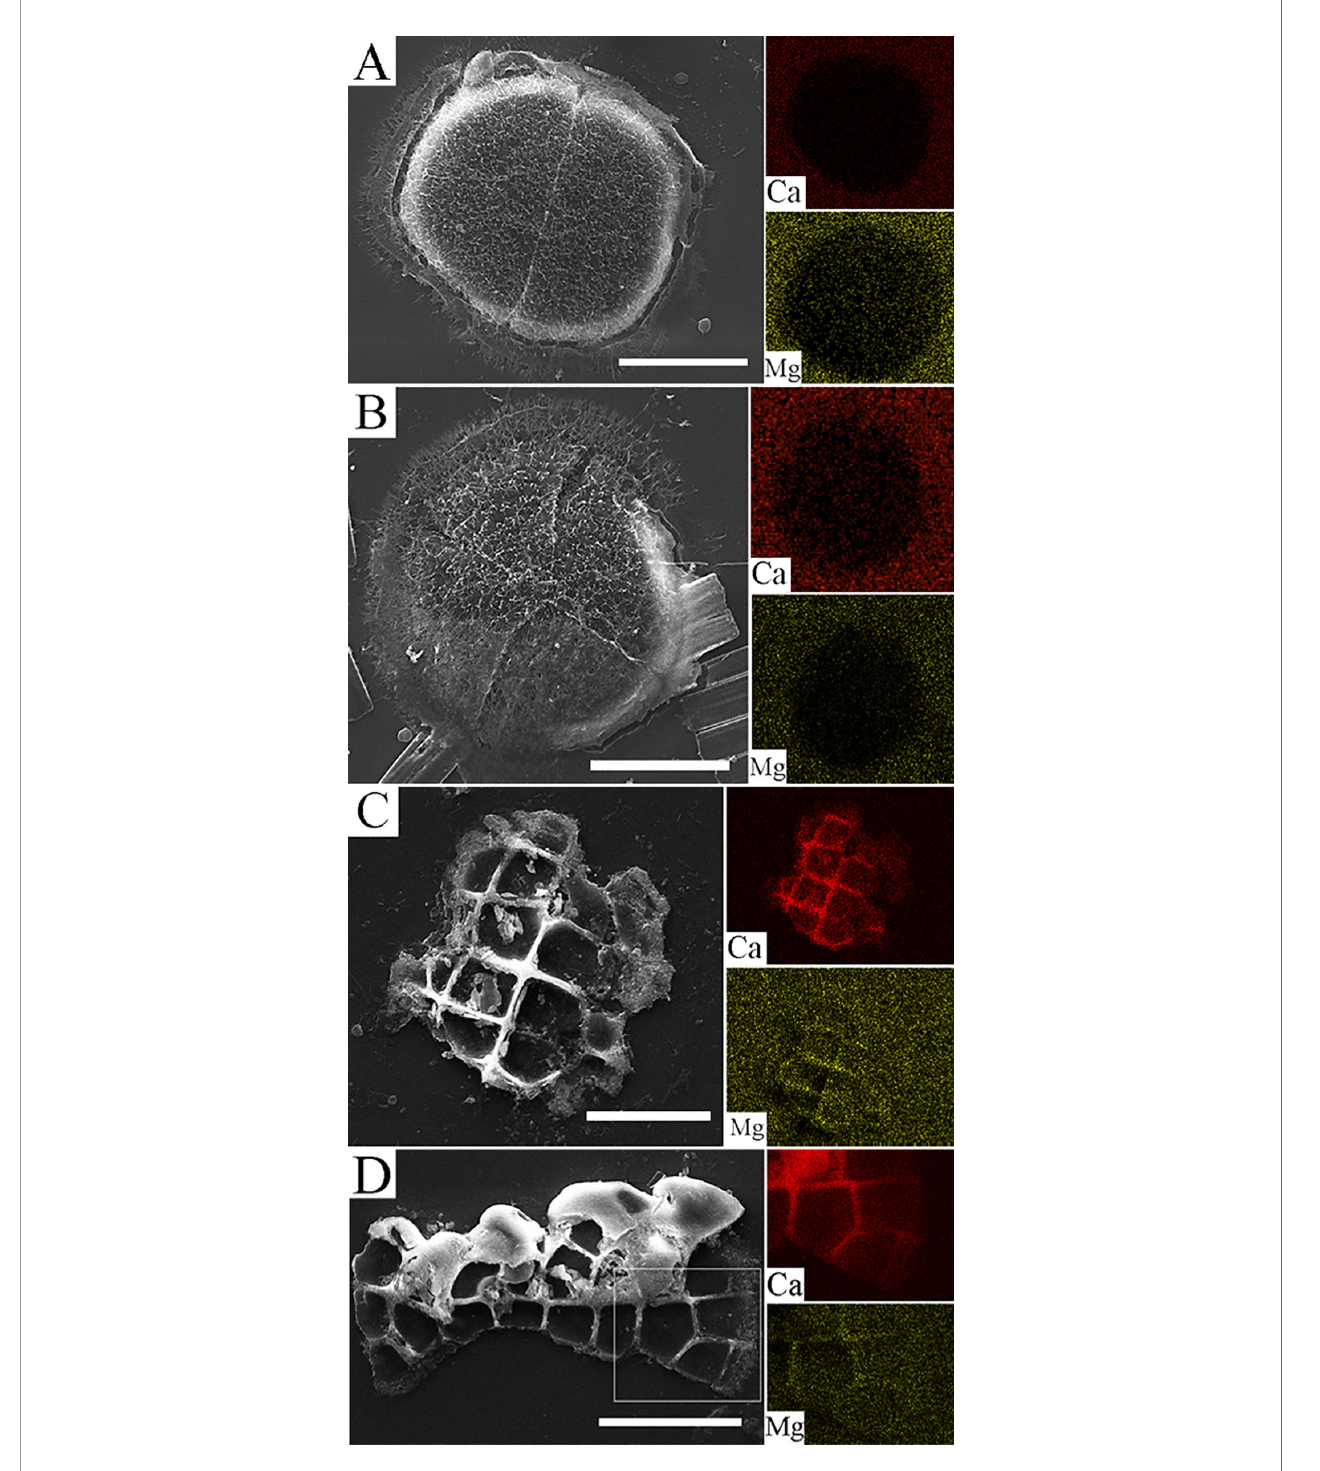
FIGURE 2 | Scanning Electron Microscopy images and EDS maps (calcium and magnesium) of L. corallinae germinating spores that settled over the microscope slides. 2 cells spore presenting a thin cell wall dividing the cells and a framework material that seems to help with the settlement process ( A , scale bar = 10 µm). 4 cells germinating spore with cruciate cell division and with the same framework material covering all the spore and part of the microscope slides ( B , scale bar = 10 µm). 12 to 16 cells germinating spore with the super fi cial tissue removed ( C , scale bar = 20 µm). 24 to 32 cells germinating spore with a fi lamentous growth, showing the small cells from divisions that occurs in the distal regions ( D , scale bar = 20